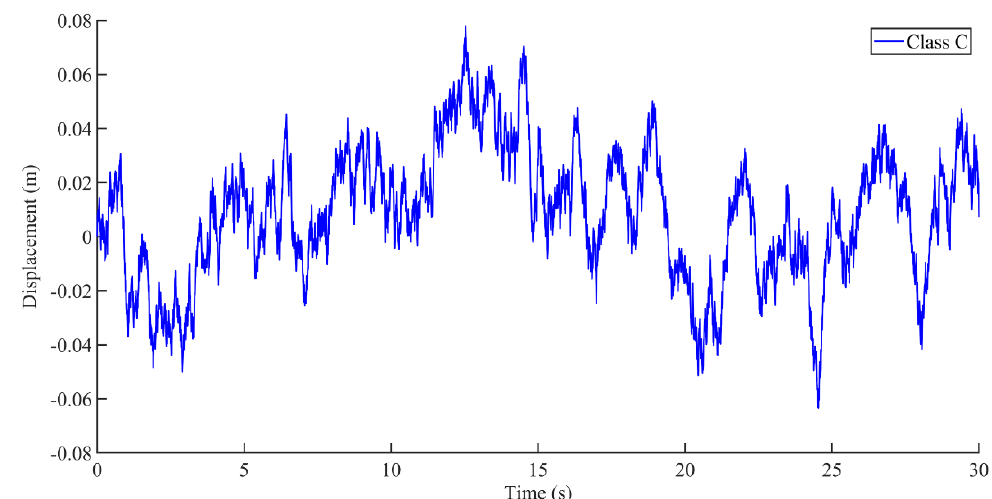
Figure 10. Road excitation under class C road surface (vehicle speed: 60 km/h).